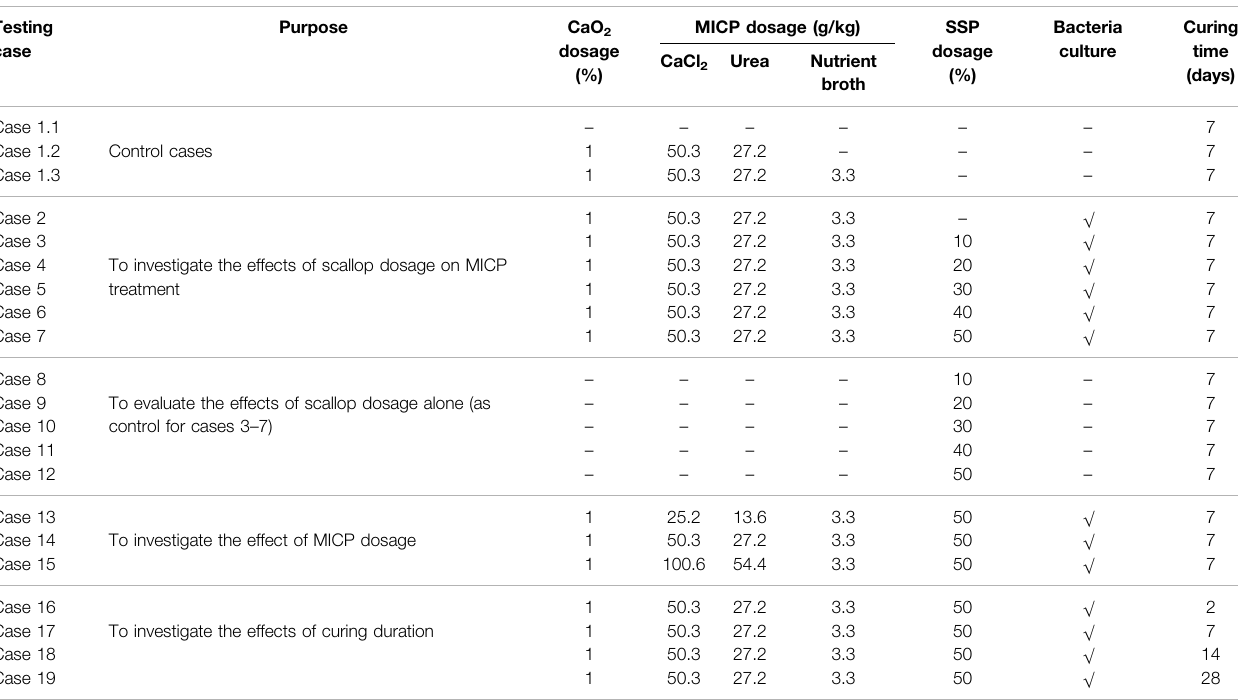
TABLE 3 | Mix designs of specimens prepared for uncon fi ned compression